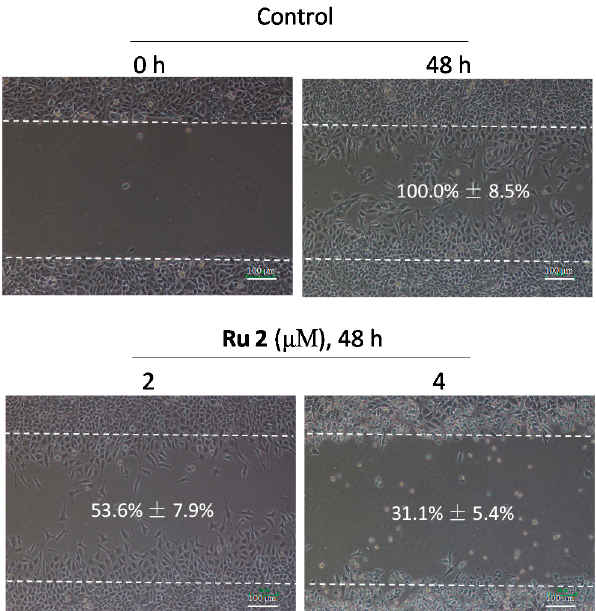
Figure 2. Effects of Ru2 on HepG2 cell migration. Cells were exposed to different Ru2 concentrations for 24 h and photographed using a phase-contrast microscope (200×, Nikon TS100, Nikon, Tokyo, Japan). Values in the images indicate the migration ability of the cells.